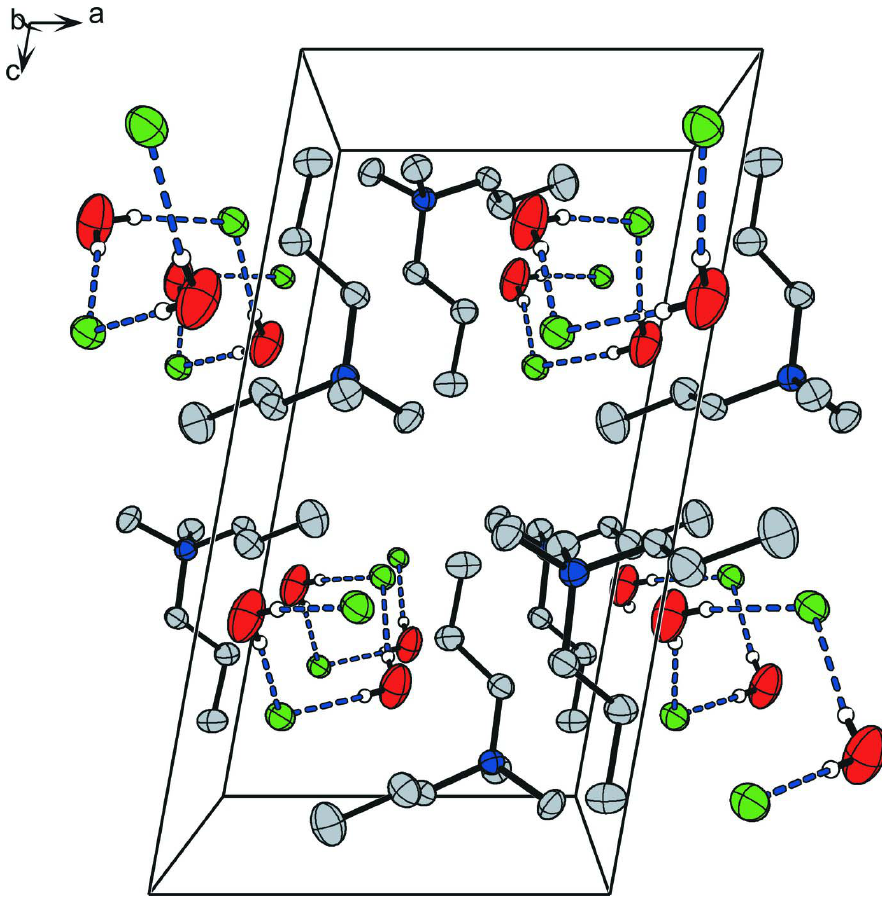
The packing of ( 1 ) viewed along the crystallographic b -axis. Dashed lines indicate hydrogen bonds. The helical structure of the network between the anions and the water molecules can be seen. The H atoms not involved in the network have been omitted for clarity, as well as some of the